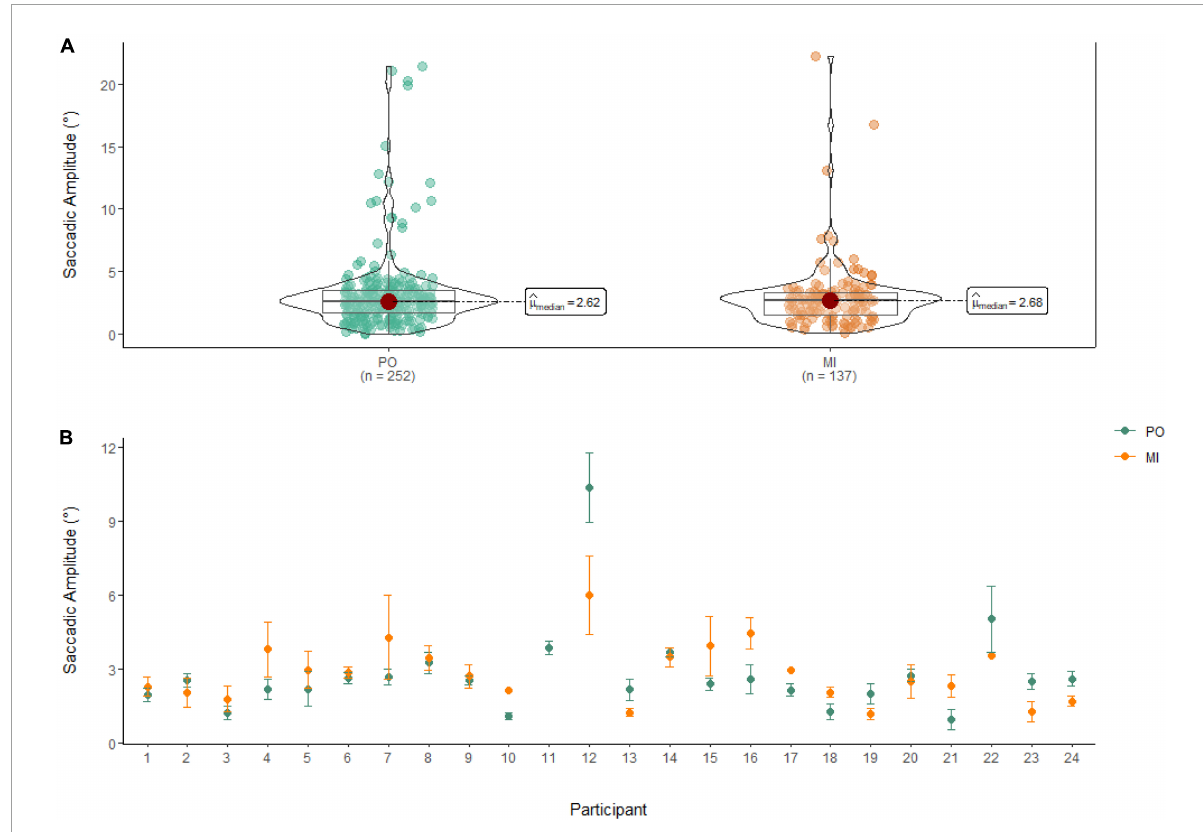
FIGURE6 (A) Similarities in saccadic amplitude between PO (left) and MI (right) after the first saccade. (B) The average amplitude of saccades for PO (blue) and MI (orange) is displayed for each of the 24 participants enrolled in the experiment. Error bars are standard error of the mean. Missing error bars indicate that only one observation was identified. With the exclusion of the first saccade, participant 11 performed no saccades during